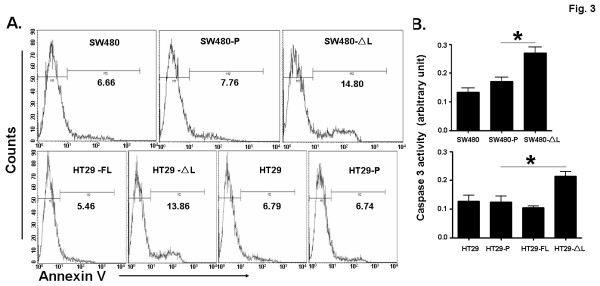
LEF-1 regulated the survival of colon cell lines. (A) LEF-1-ΔL or LEF-1-FL was expressed stably in SW480 and HT29 cells, and cell death was examined by annexin V-FITC/PI staining. The numbers in images are the percentages of annexin V positive cells. (B) The caspase-3 activity was assessed in the cell lines that expressed LEF-1-ΔL or LEF-1-FL. *P < 0.05.